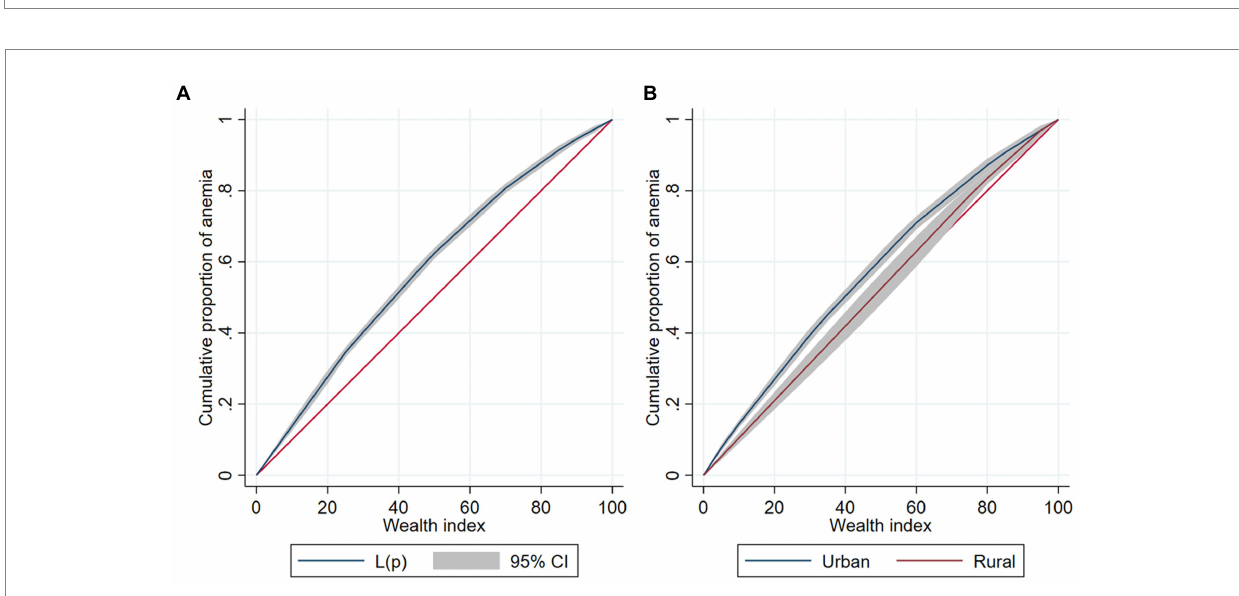
FIGURE 3 Concentration curve of anemia among Peruvian children (A) . Overall concentration curve of anemia. (B) Concentration curve of anemia stratified by area of